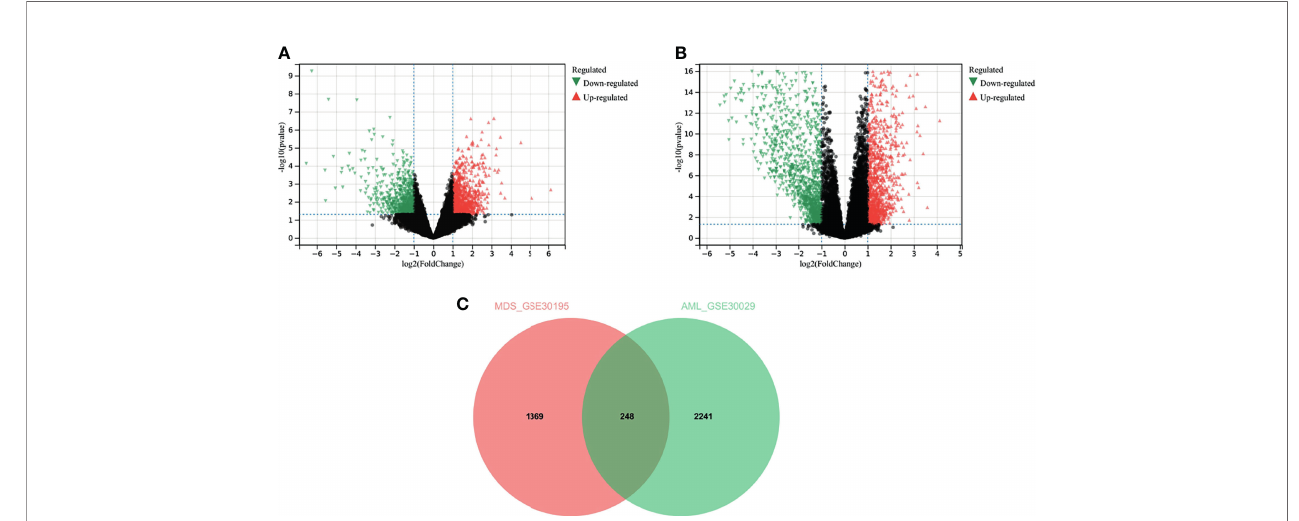
FIGURE 2 | Results of analysis of variance. (A) analysis of variance for the MDS dataset GSE30195; (B) analysis of variance for the AML dataset GSE30029; (C) Venn diagram for the overlapping genes of the two sets of